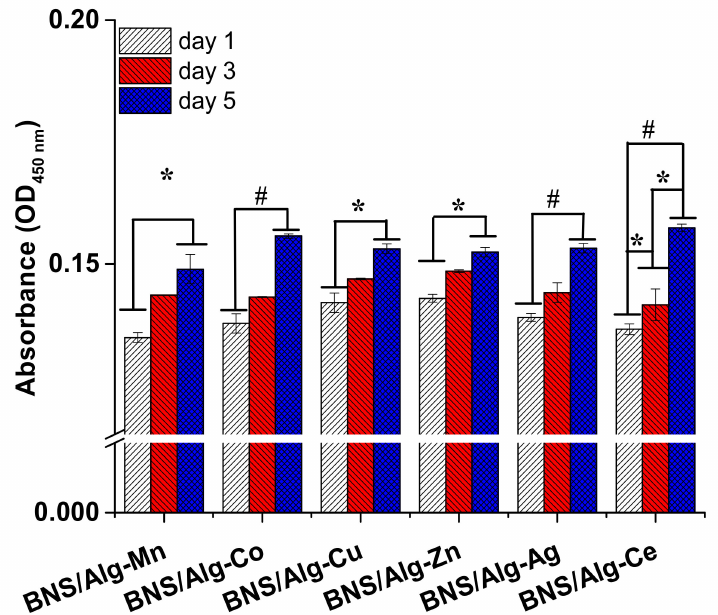
Figure 6. Cytotoxicity evaluation of the synthesized dressing materials using CCK-8 for L929 cells. * p < 0.05, # p < 0.001 (n = 3) using Student’s t -test